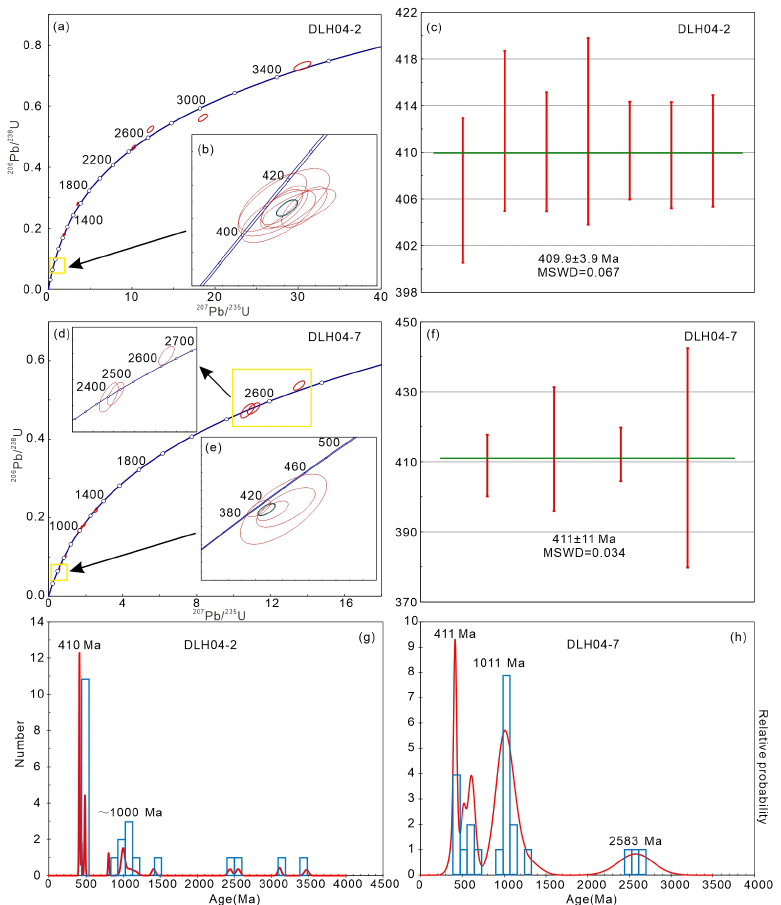
Figure 6. Zircon U - Pb age diagrams of felsic volcanic rocks in the Maoniushan Formation. ( a , b ) U - Pb concordia diagrams of DLH04 - 2 sample; ( c ) 206 Pb/ 238 U weighted mean ages of DLH04 - 2 sample; ( d , e ) U - Pb concordia diagrams of DLH04 - 7 sample; ( f ) 206 Pb/ 238 U weighted mean ages of DLH04 - 7 sample; ( g ) U - Pb age histogram of zircons from DLH04 - 2 sample; ( h ) U - Pb age histogram of zircons from DLH04 - 7 sample.